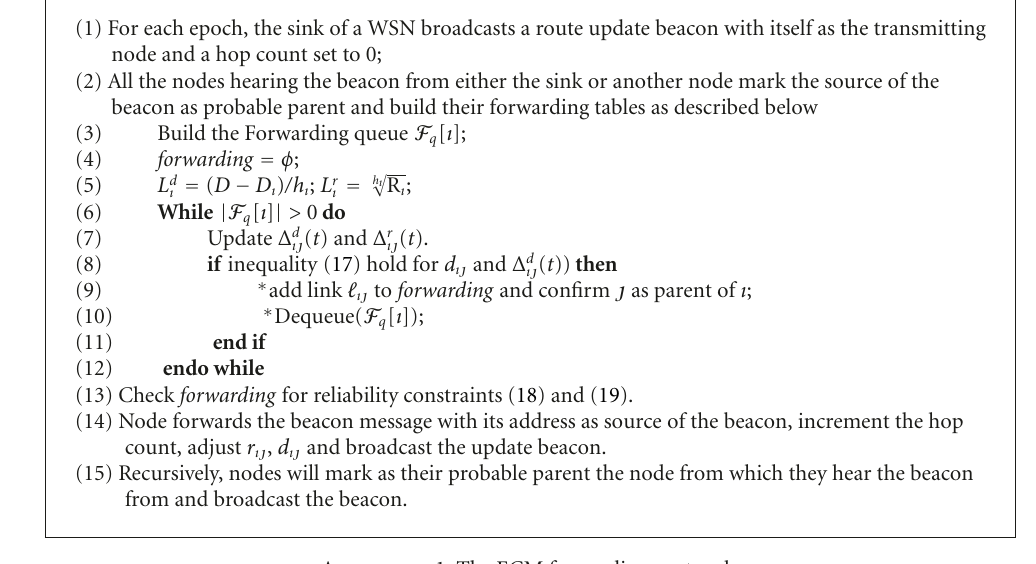
Algorithm 1: The ECM forwarding protocol.